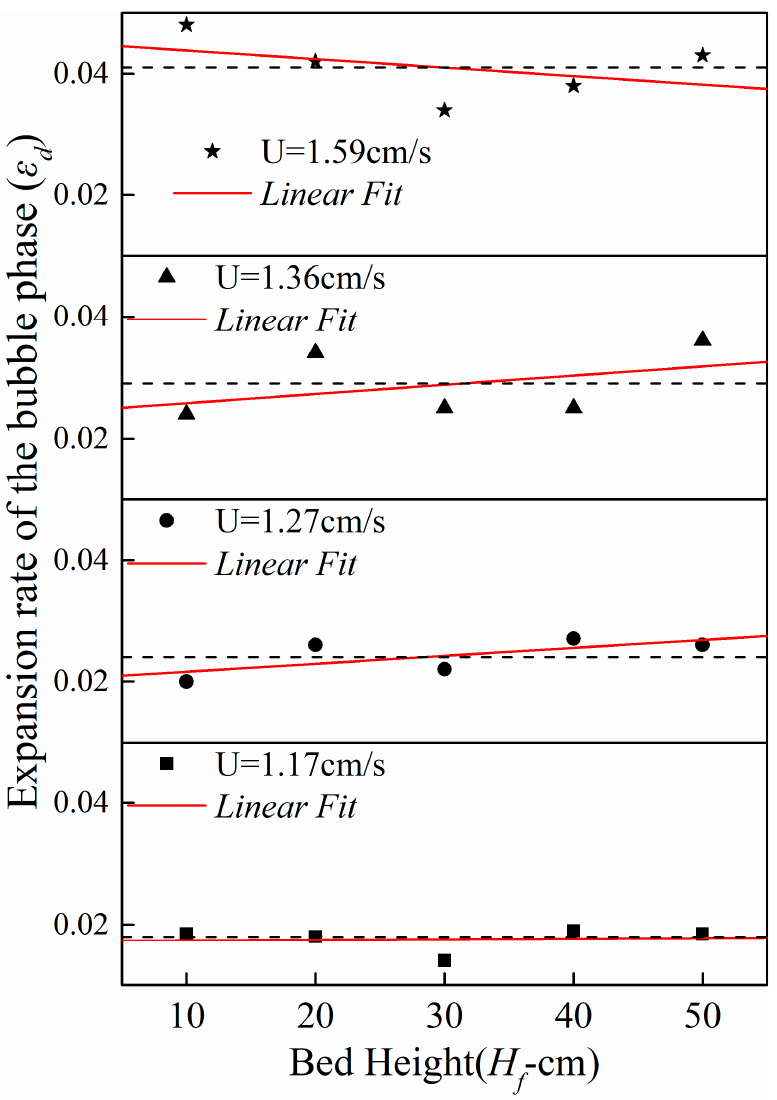
Figure 8. Effect of the bed height on the expansion of the bubble